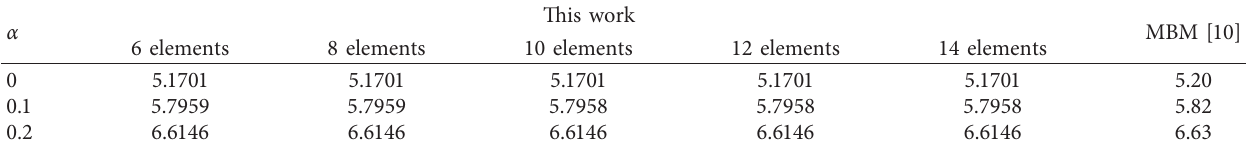
Table 1: Nondimensional maximum deflections w of the FGM porous beam under uniformly distributed load, S-S, L / h � 5 and n � 2.